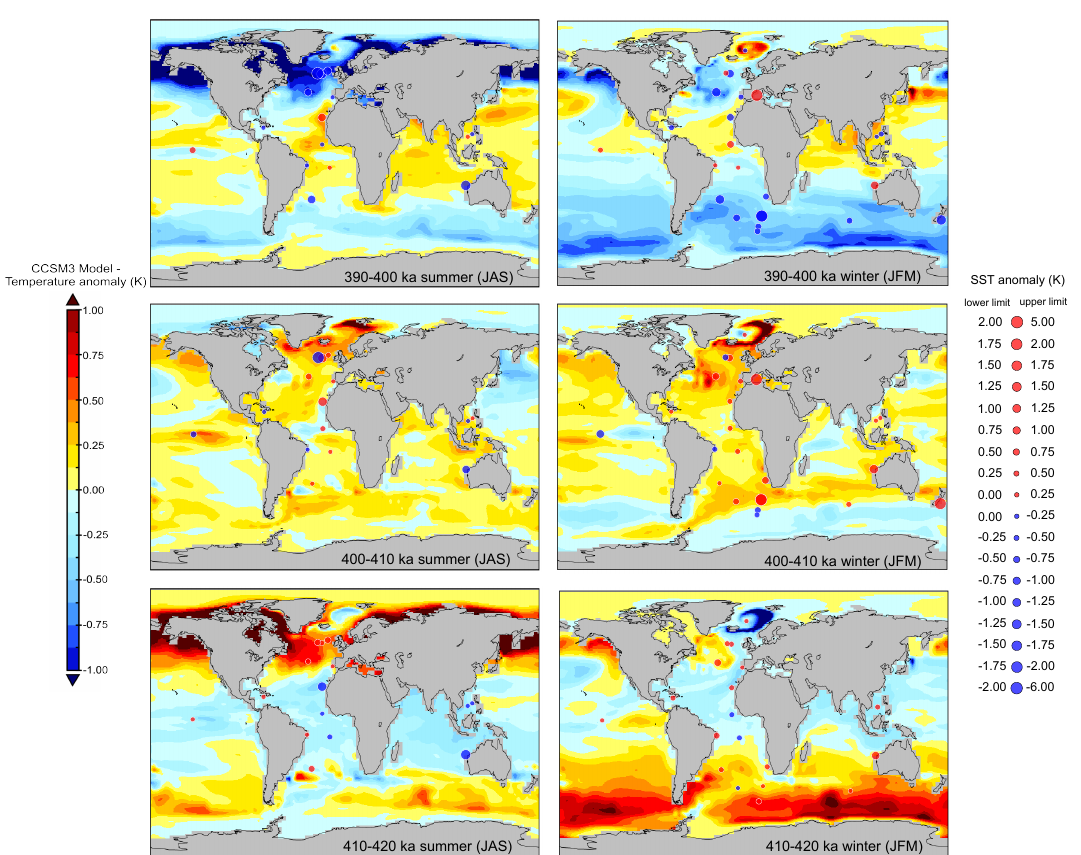
Fig. 6. A comparison of the boreal summer and winter sea surface temperature anomalies of proxy records with CCSM3 climate model results for 390–400, 400–410 and 410–420ka time slices. Color and size scales indicate the magnitude of temperature anomalies relative to the mean SST of the three time